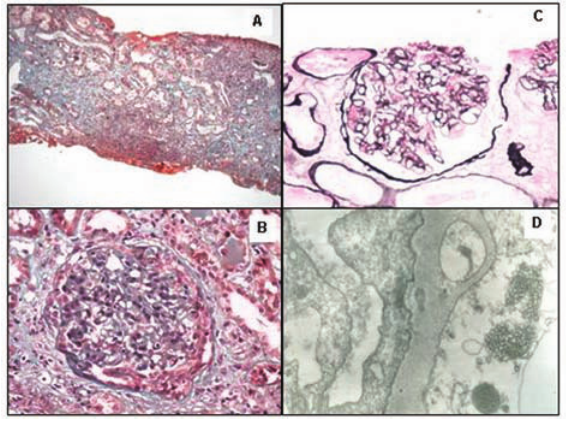
Figure 1 - Kidney biopsy: Panel A shows extensive fibrosis, appearing in trichrome stain (1,25×) as green areas. Panel B (Masson stain - 400×) shows global hipercelularity, mostly of mesangial cells and a cellular crescent formation on the right side (arrow). Panel C shows a silver stain exhibiting occasional double contours of the glomerular basement membrane (arrox - 400×). Panel D reveals a high power electron micrograph abundant tubuloreticular inclusions in the cytoplasm of glomerular endothelial